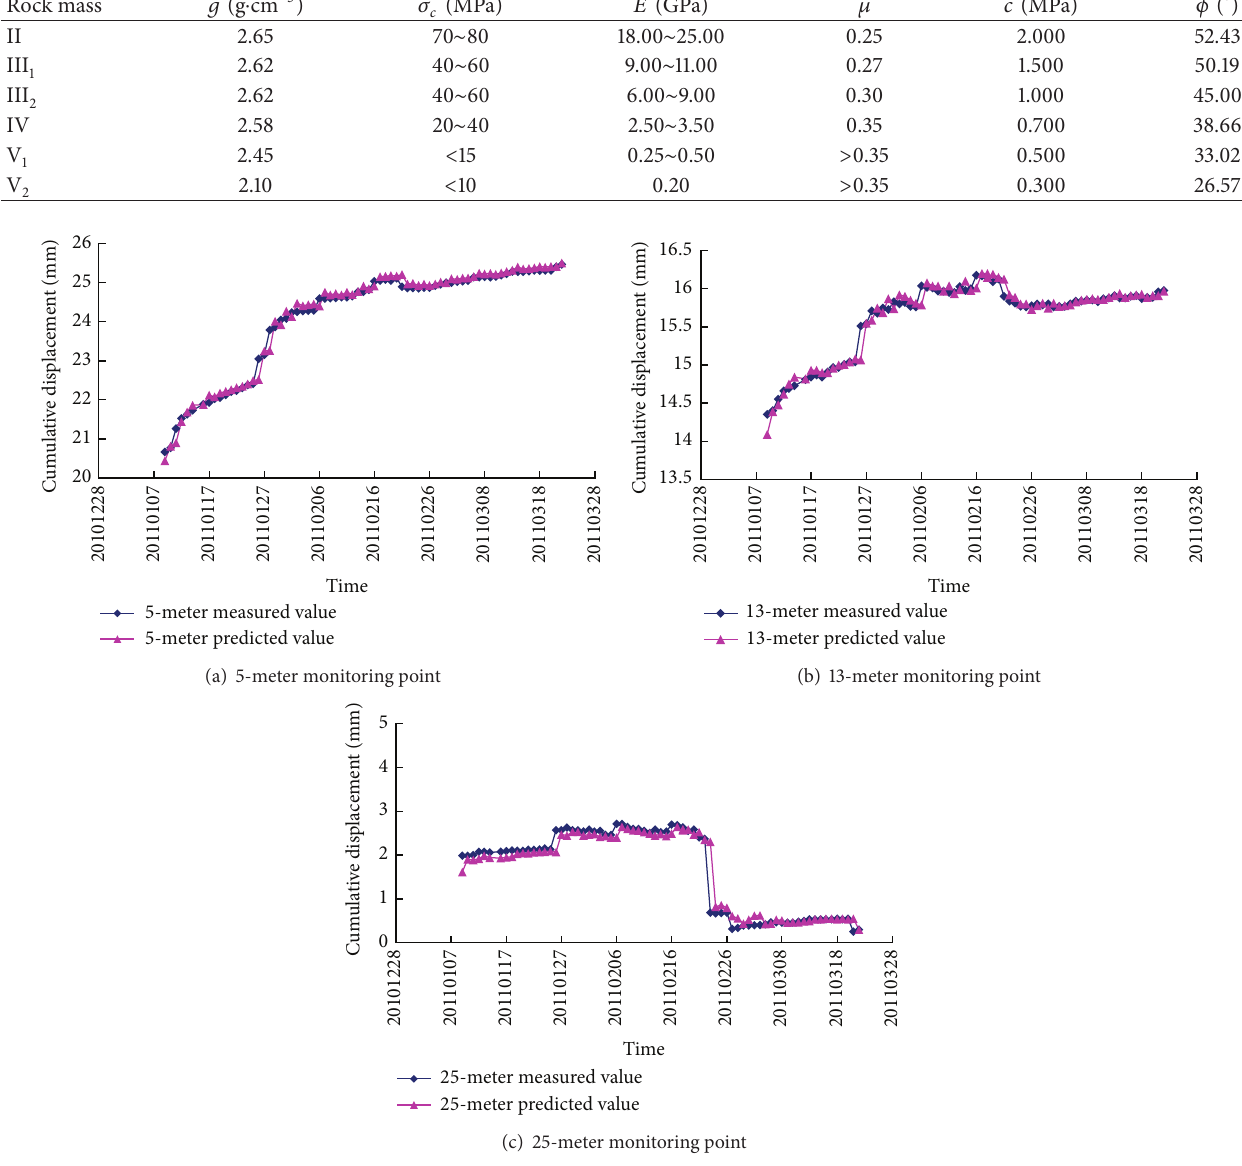
Figure 8: Displacement comparison between the measured displacements and the predicted displacements.